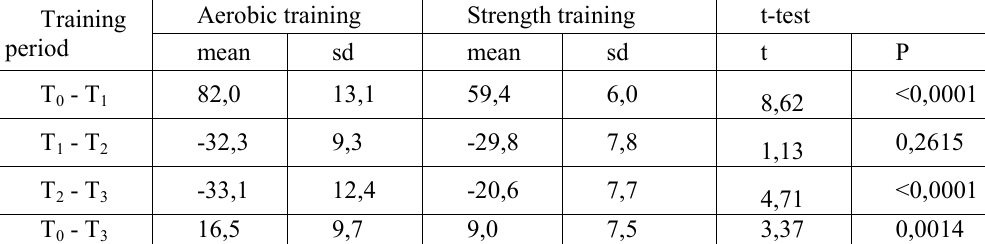
Mean HR values comparison in both training groups *) . Negative values indicate